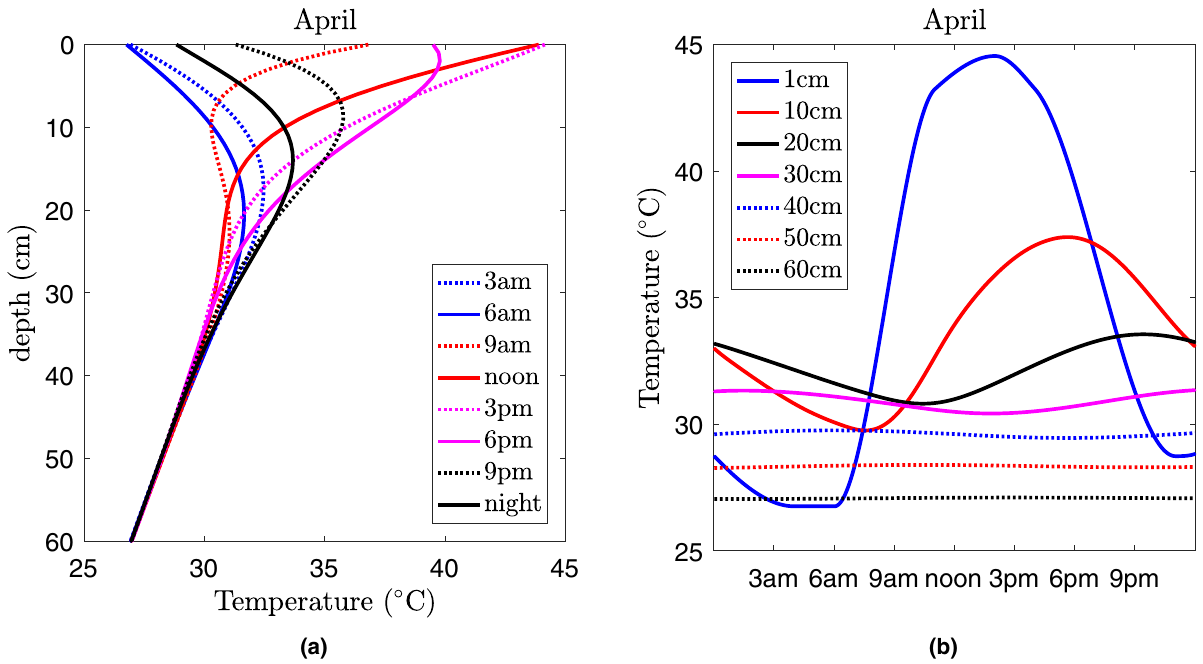
Figure 3. Vertical distribution of the temperature across the soil ( a ) and daily temperature variation at a fixed depth of the soil ( b ) for the first day of April in a typical field in Nakhon Phanom province in Thailand predicted by the heat equation (2) using historical surface temperature data for the period of